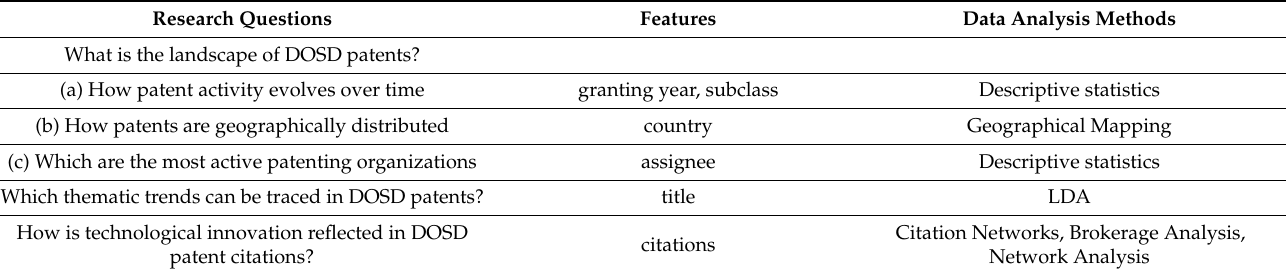
Table 3. Research goals, research questions and features on patent